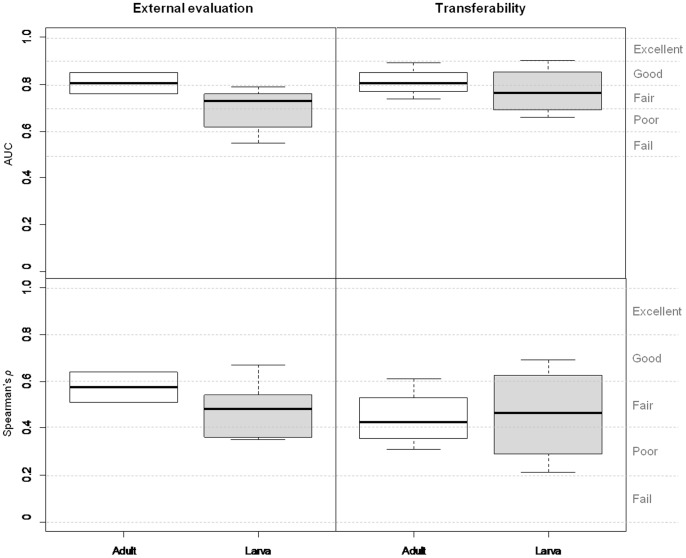
Boxplots of the measures (AUC and Spearman’s ρ) of predictive accuracy and transferability.Predictive accuracy measures of the abiotic (ABIOT) minimal adequate models (MAMs) (left) were derived by external evaluation (i.e., two independent calibration-evaluation data sets from locations A and B). Transferability measures of the ABIOT MAMs (right) indicate their cross-applicability between life stages. The plotted values for adult model transferability indicate the ability of adult models to predict larval occurrence. The plotted values for larval model transferability indicate the ability of larval models to predict adult occurrence.